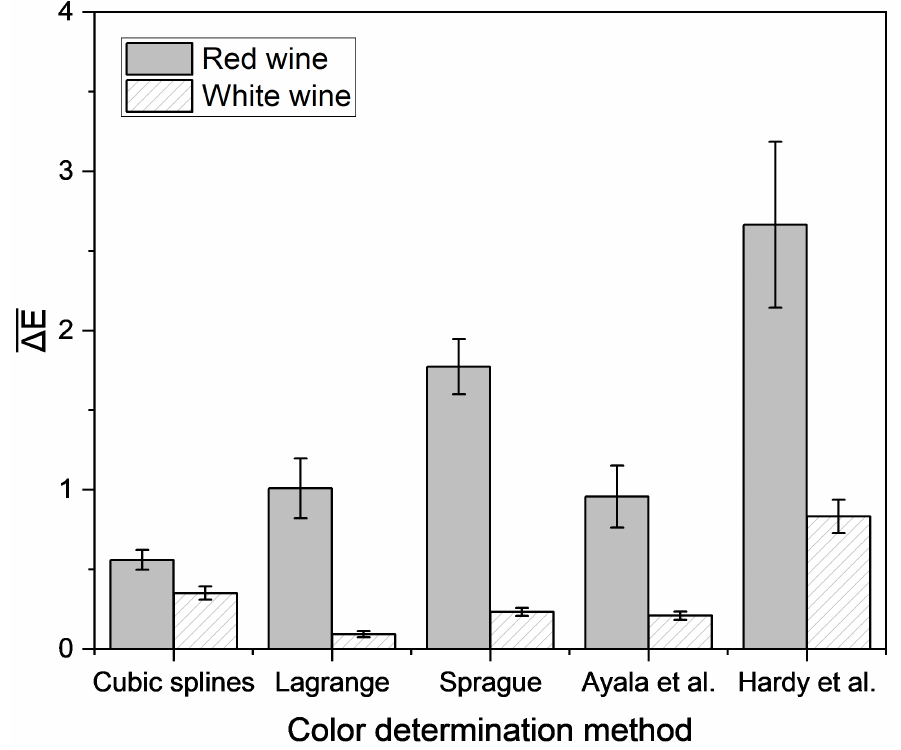
Figure 7. Mean Euclidean color distance in the CIE L*a*b* color space based on different empir- ical methods and the reconstructed transmission spectra, determined by different interpolation approaches compared with the color determination method according to OIV [51]. Transmission data were measured with a laboratory photometer. Mean and 95% confidence interval of 56 red and 56 white wines are